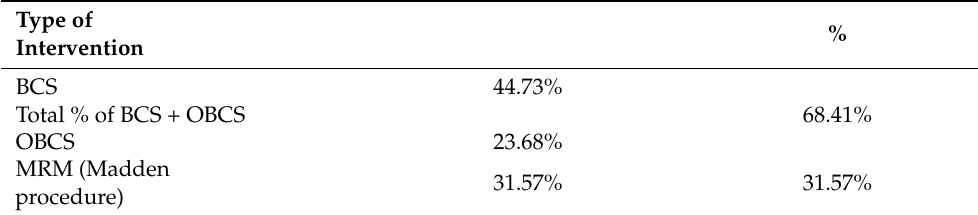
Table 2. Case classification based on surgery type for Group A.